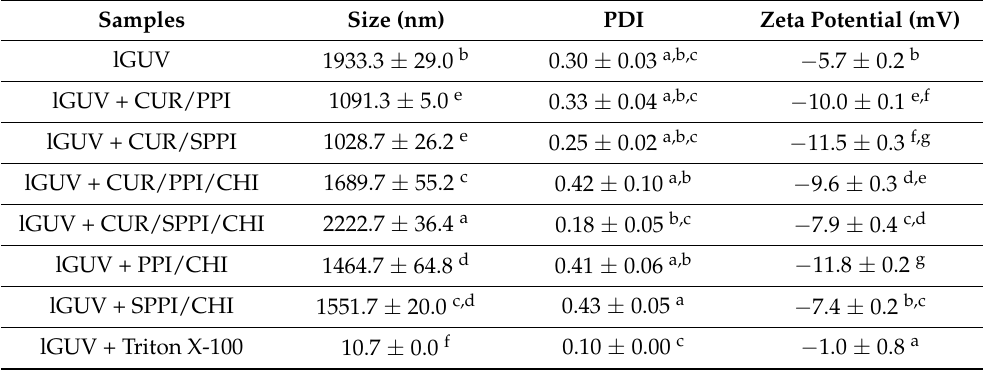
Table 1. Changes in size, polydispersity index, and zeta potential of calcein-loaded GUV after interaction with the hollow or curcumin-loaded protein nanoparticles or Triton X-100. Samples Size (nm) PDI Zeta Potential (mV) lGUV 1933.3 ± 29.0 b 0.30 ± 0.03 a,b,c − 5.7 ± 0.2 b lGUV + CUR/PPI 1091.3 ± 5.0 e 0.33 ± 0.04 a,b,c − 10.0 ± 0.1 e,f lGUV + CUR/SPPI 1028.7 ± 26.2 e 0.25 ± 0.02 a,b,c − 11.5 ± 0.3 f,g lGUV + CUR/PPI/CHI 1689.7 ± 55.2 c 0.42 ± 0.10 a,b − 9.6 ± 0.3 d,e lGUV + CUR/SPPI/CHI 2222.7 ± 36.4 a 0.18 ± 0.05 b,c − 7.9 ± 0.4 c,d lGUV + PPI/CHI 1464.7 ± 64.8